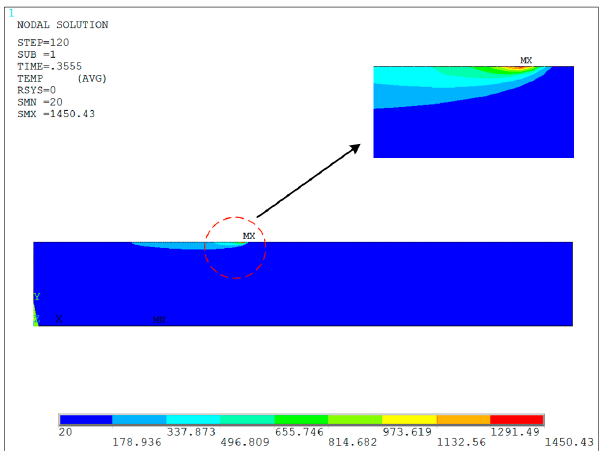
Figure 3. Temperature field in grind-hardening process ( a p = 450 μ m, v w = 10 m/min, v s = 26.4 m/s).